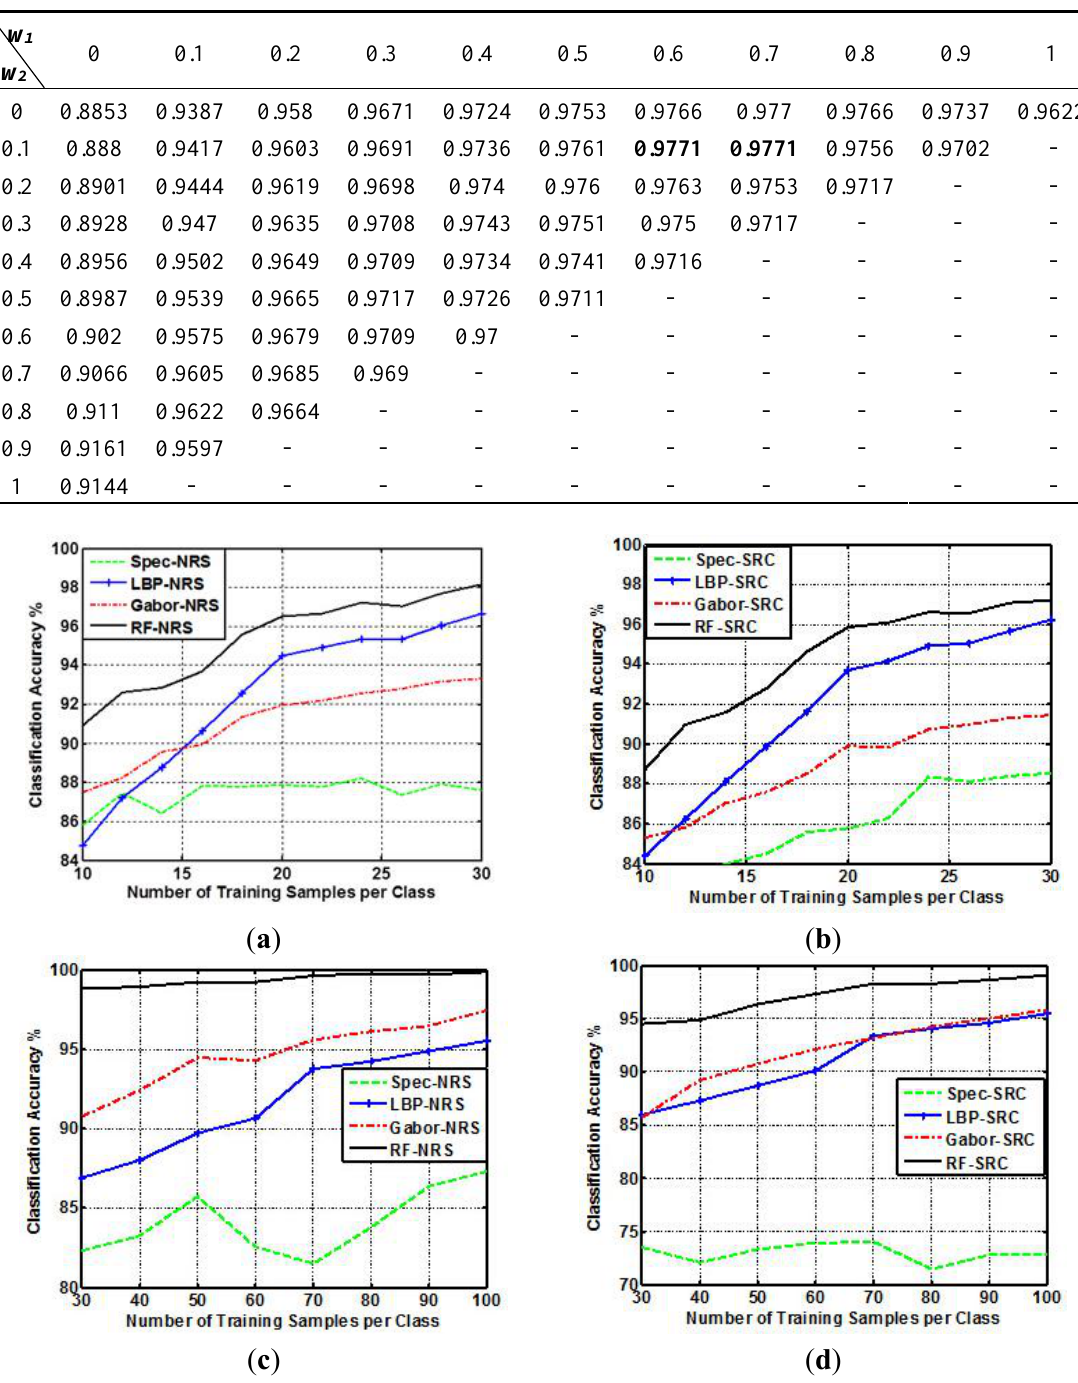
Table 6. Classification accuracy (%) versus the values of Salinas dataset with 30 training samples per class.